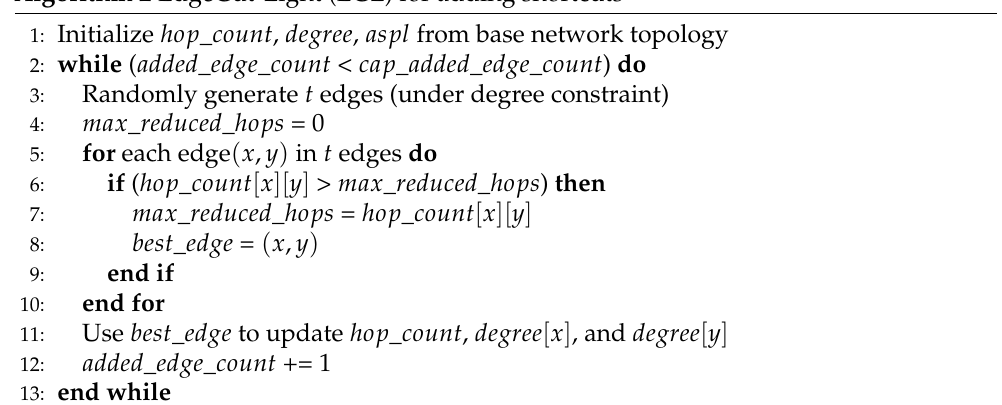
Algorithm 2 EdgeCut-Light (ECL) for adding